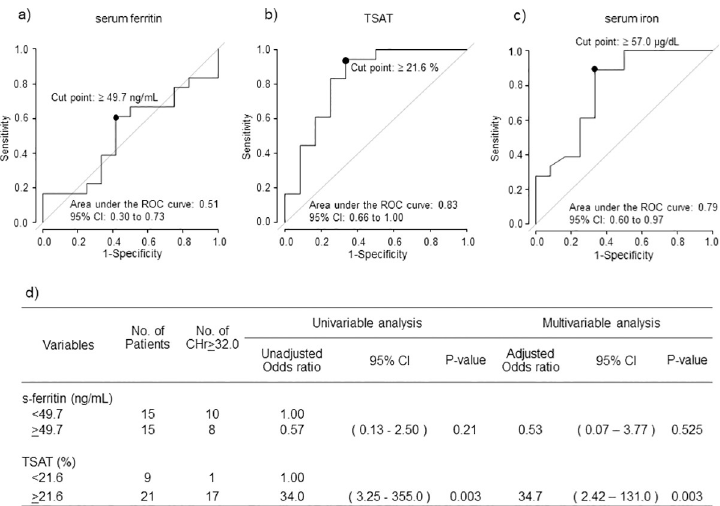
Fig 1. CHr levels and iron status on Day 0. ROC curves of (a) serum ferritin (b) TSAT and (c) s-Fe for CHr � 32.0 pg on Day 0. The respective cutoff values for s-ft, TSAT, and s-Fe were � 49.7 ng/mL (sensitivity 58.3%, specificity 61.1%, AUC 0.51), 21.6% (sensitivity 66.7%, specificity 94.4%, AUC 0.83, 95% CI 0.66–1.00), and 57.0 μ g/dL (sensitivity 66.7%, specificity 94.4%, AUC 0.79, 95% CI 0.60–0.97). (d) Logistic model analysis with CHr � 32.0 pg as the